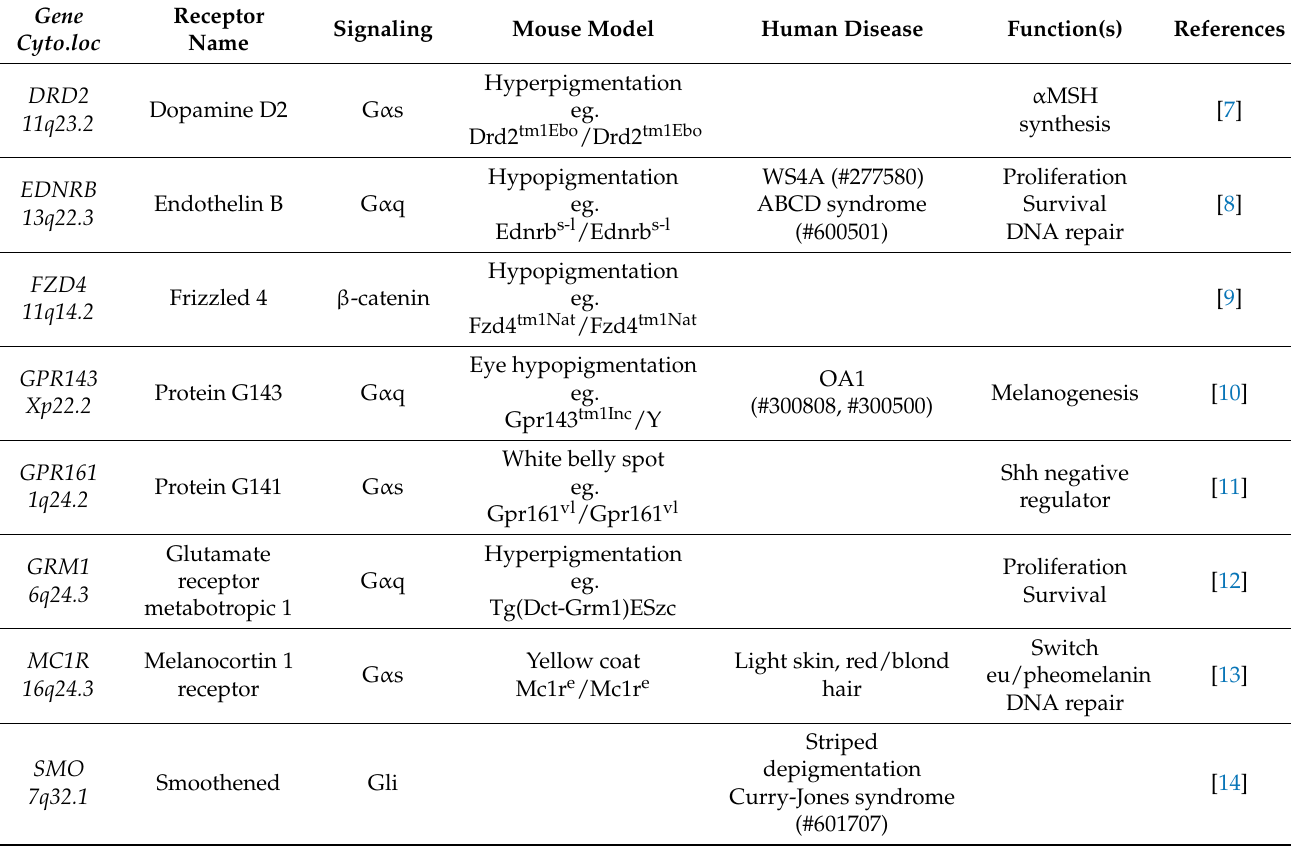
Table 1. GPCR and pigmentation GPCRs involved in pigmentary phenotypes in mouse and